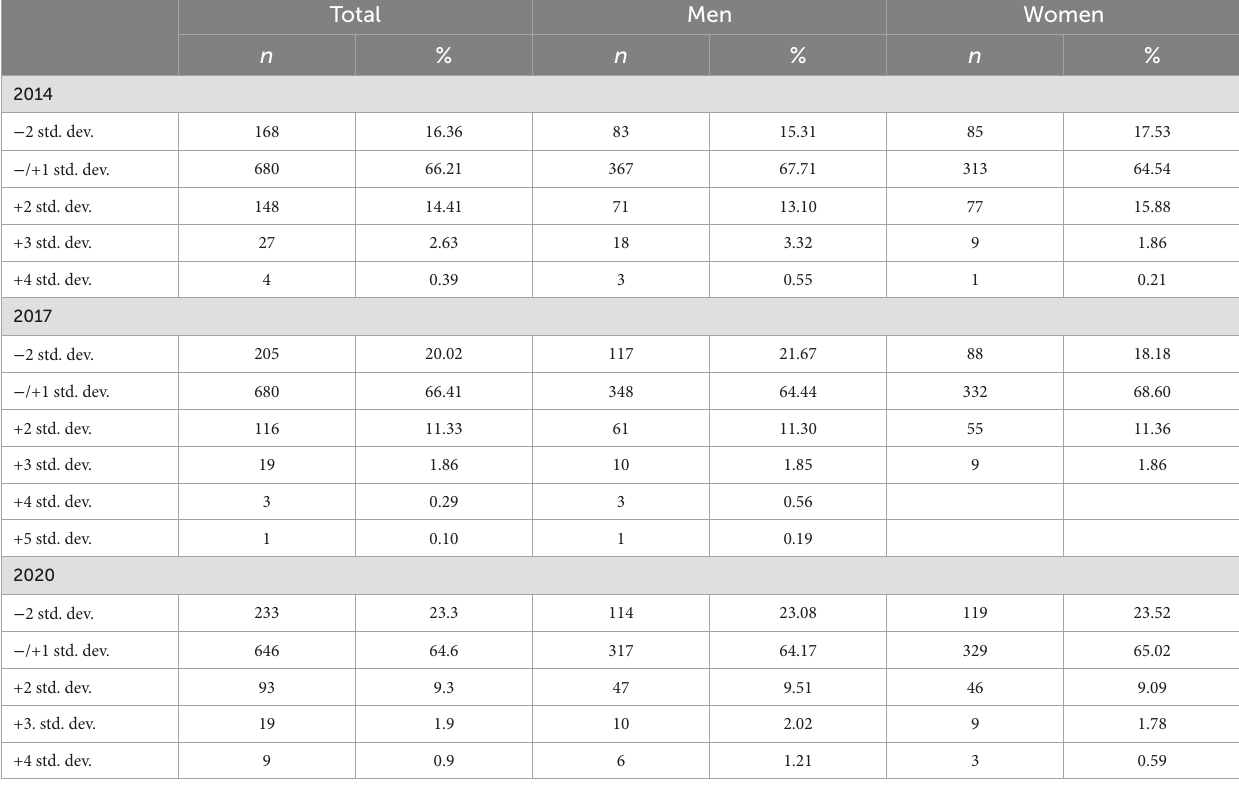
TABLE 4 Burnout according to